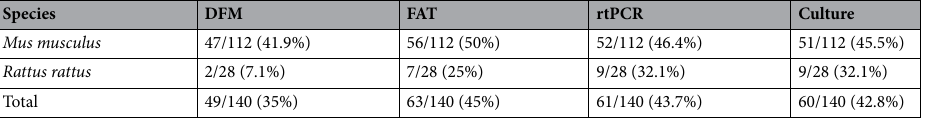
Table 3. Detection of Leptospira in different rodent species from different study sites by dark-field microscopy (DFM), fluorescent antibody test (FAT), real-time polymerase chain reaction (rtPCR), and culture.